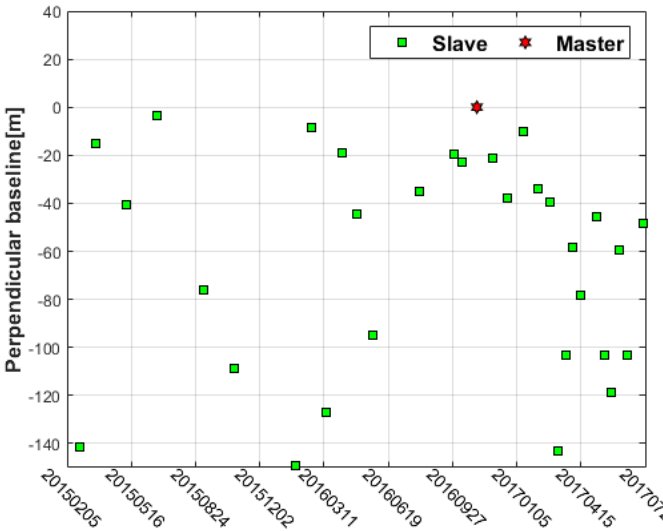
Figure 2. Temporal–spatial